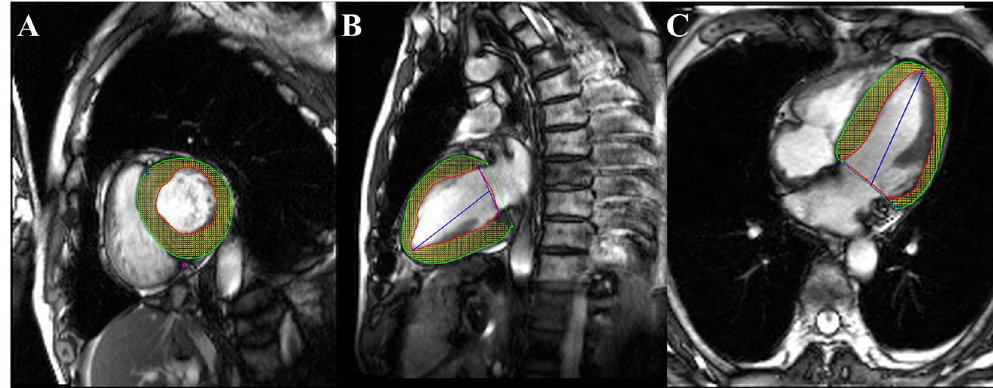
Figure 2. CMR feature tracking in short-axis ( A) , two-chamber ( B ) and four-chamber long-axis ( C ) cine images at the end-diastole. The red and green curves show the endocardial and epicardial borders, respectively; the yellow dots represent the myocardial voxel points. Abbreviations: CMR, Cardiovascular magnetic